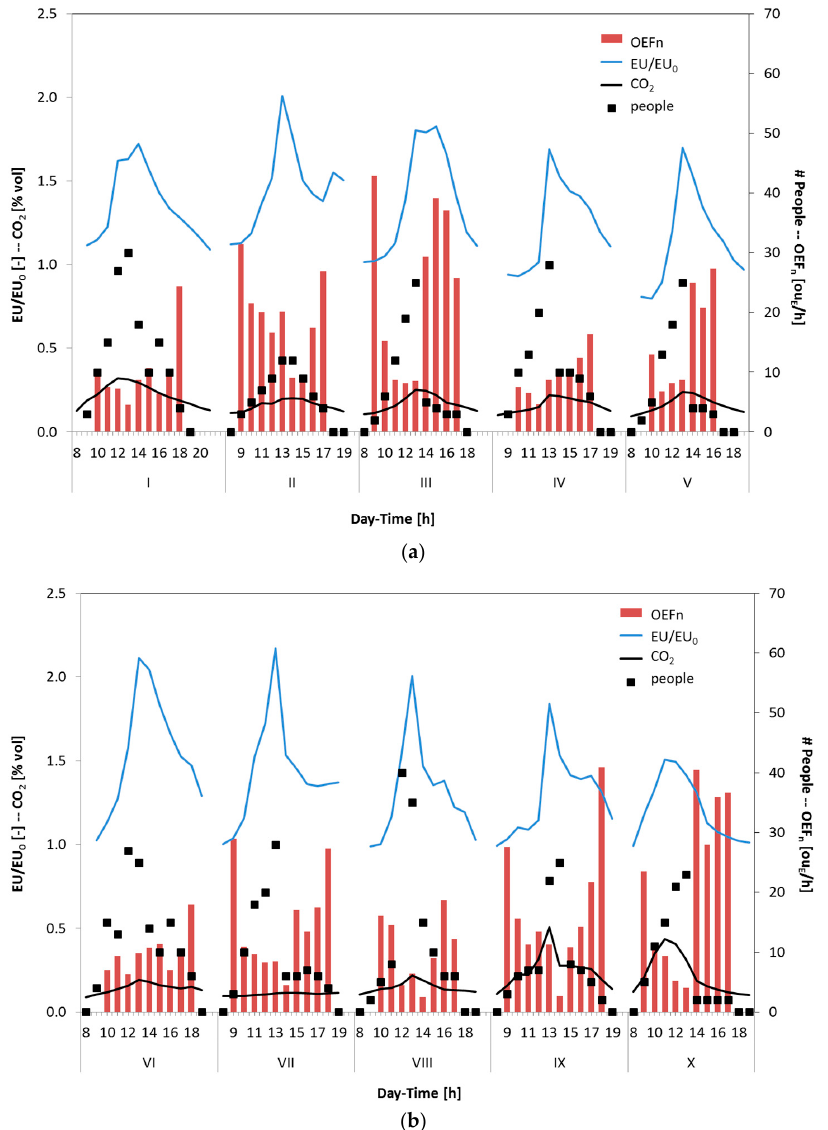
Figure 5. Trends of EU/EU 0 , CO 2 concentration, number of occupants and estimated OEF n for the period from day I to V ( a ); and for the period from day VI to X ( b ).